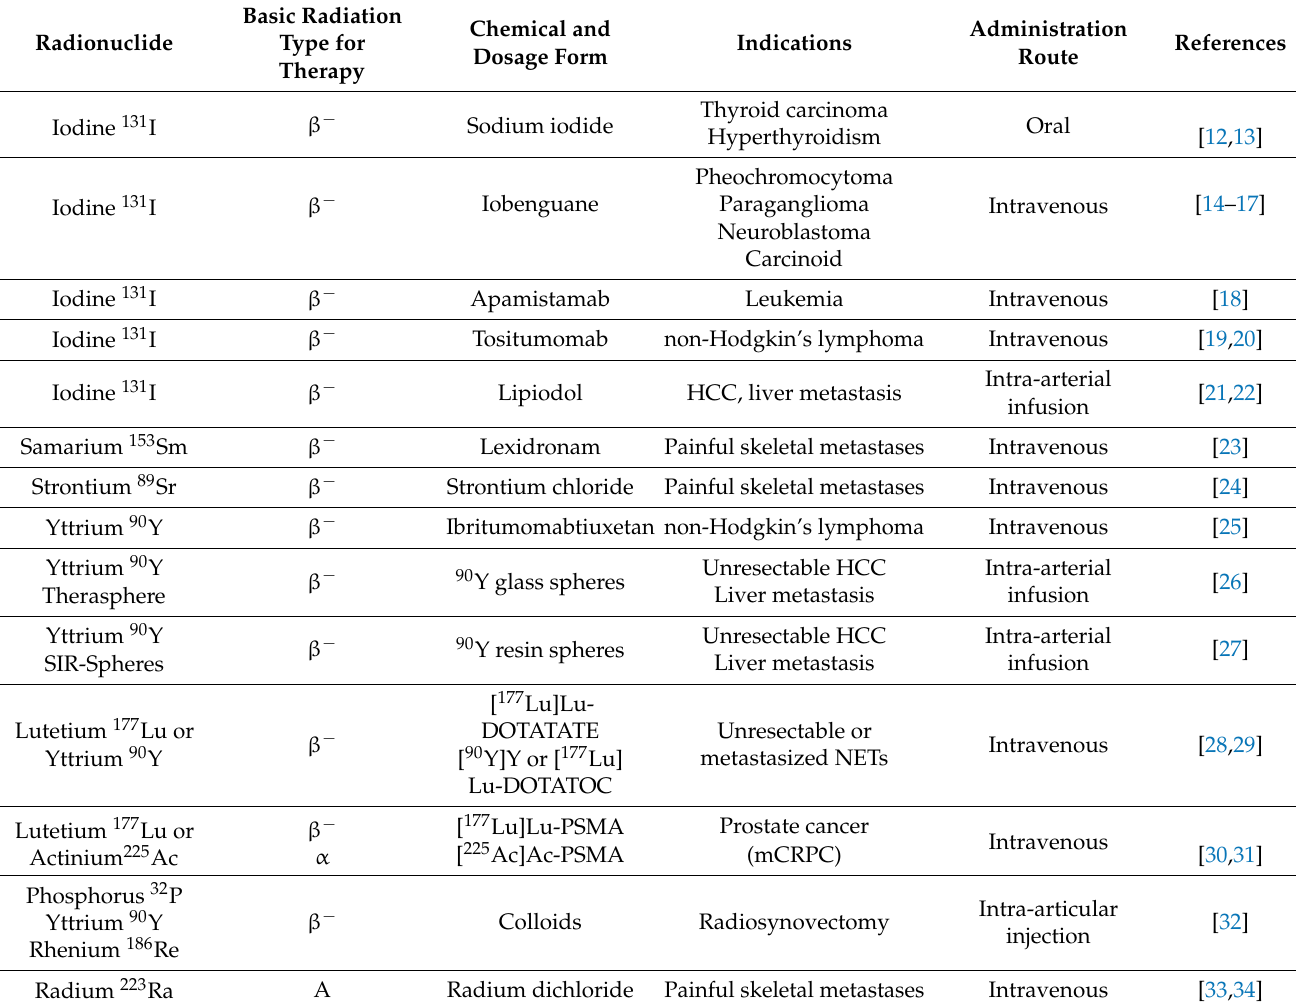
Table 1. Radionuclides used in particular types of radioisotope